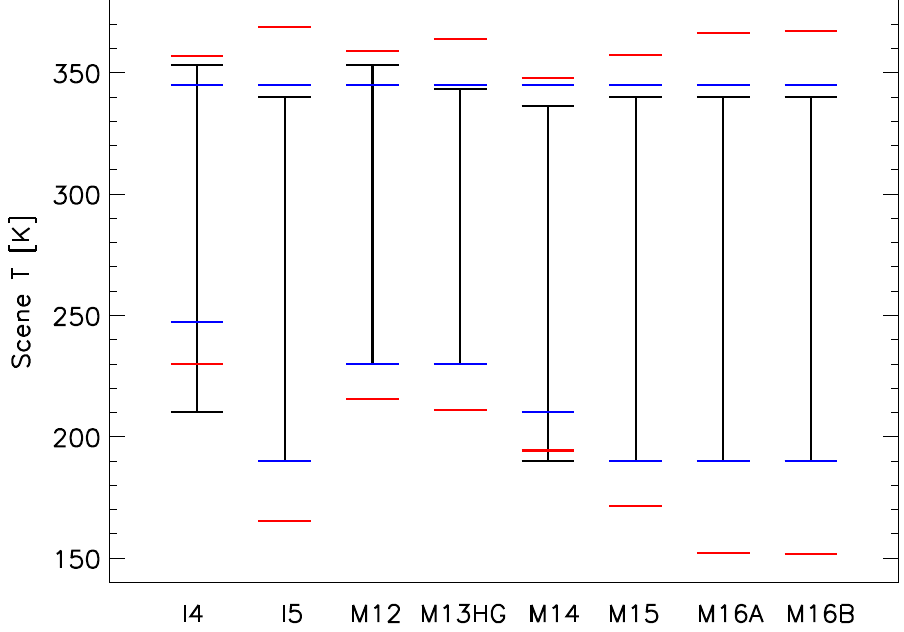
Figure 1. Specified dynamic ranges shown for the VIIRS thermal bands (black lines). Maximum and minimum scene temperatures used in the fitting as shown with blue lines. Saturation and low temperature SNR threshold are also shown (red